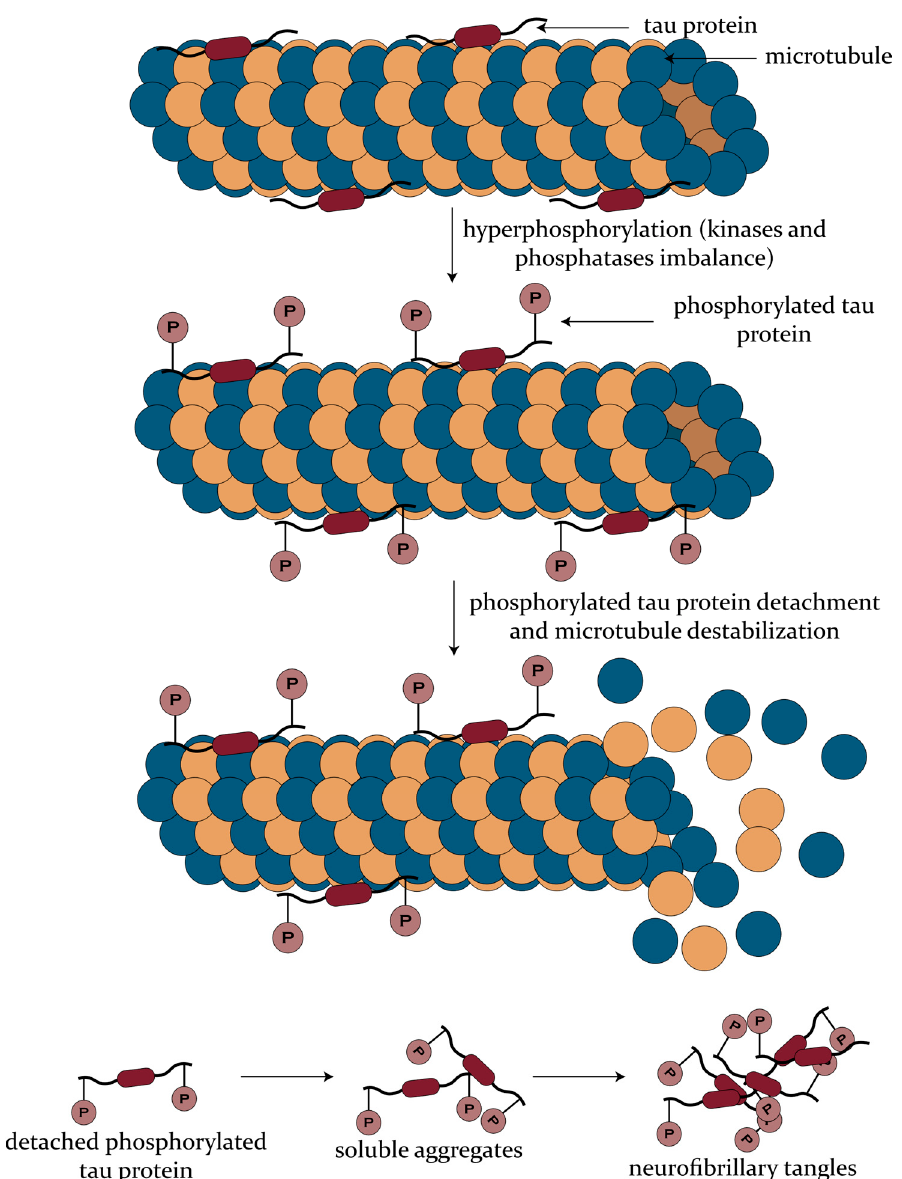
Figure 2. The formation of neurofibrillary tangles through the process of tau protein Figure 2. hyperphosphorylation.